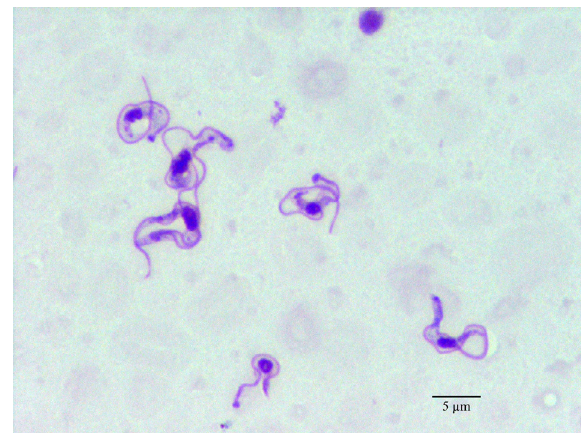
Figure 2. Trypanosoma evansi , dog, Giemsa-stained blood